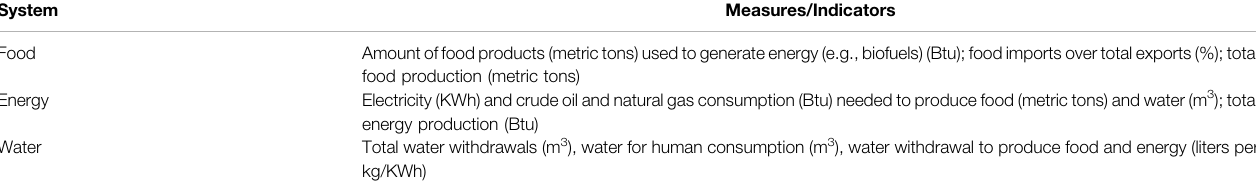
TABLE 1 | Measures and indicators of FEW systems. System Measures/Indicators